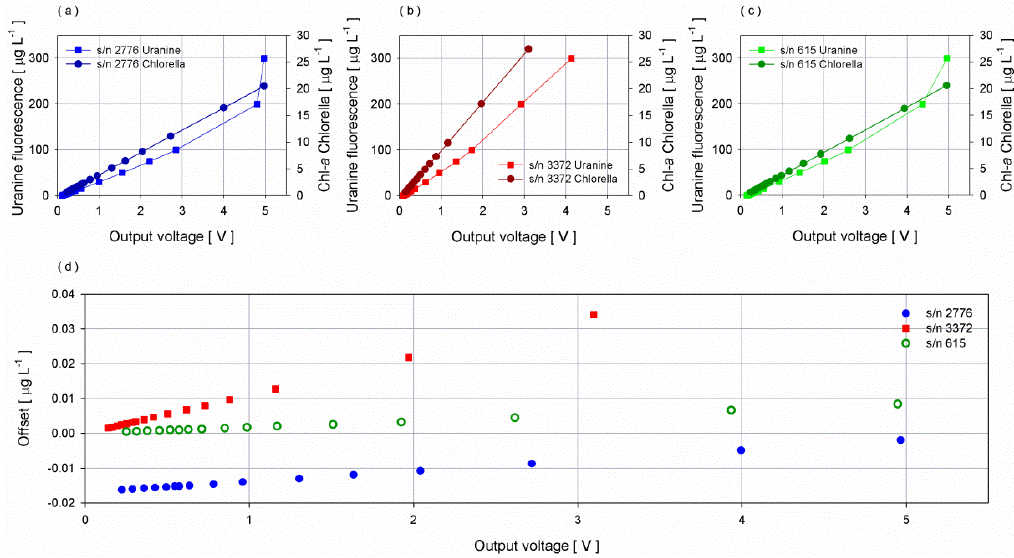
Figure 12. Dispersion diagrams of chlorophyll- a concentrations of Chlorella and fluorescence of Uranine vs. fluorometers response for sensor ( a ) s/n 2776, ( b ) s/n 3372 and ( c ) s/n 615. ( d ) Offset between the chlorophyll- a estimates using the shifted curve from the dye solution and the Chlorella concentration.